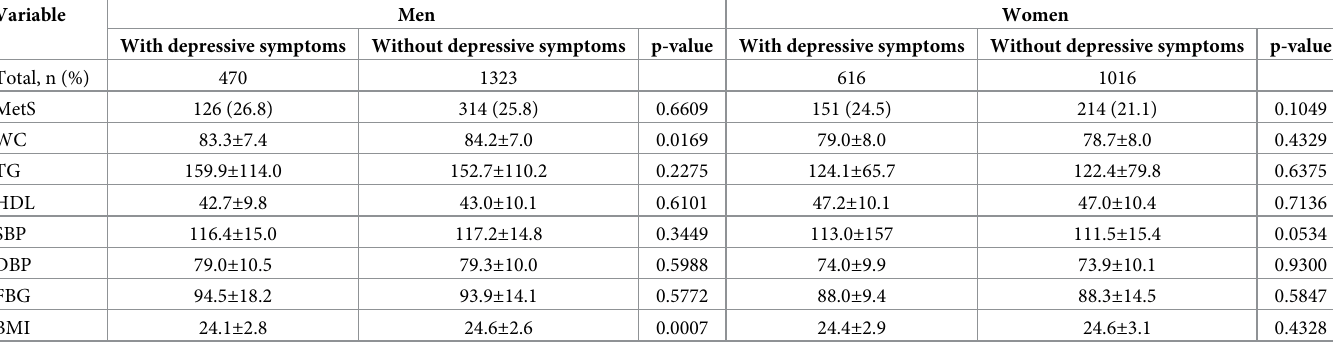
Table 1. Metabolic syndrome components of subjects with and without depressive